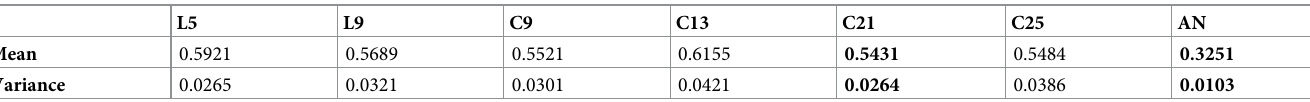
Table 7. IGD experimental result for different